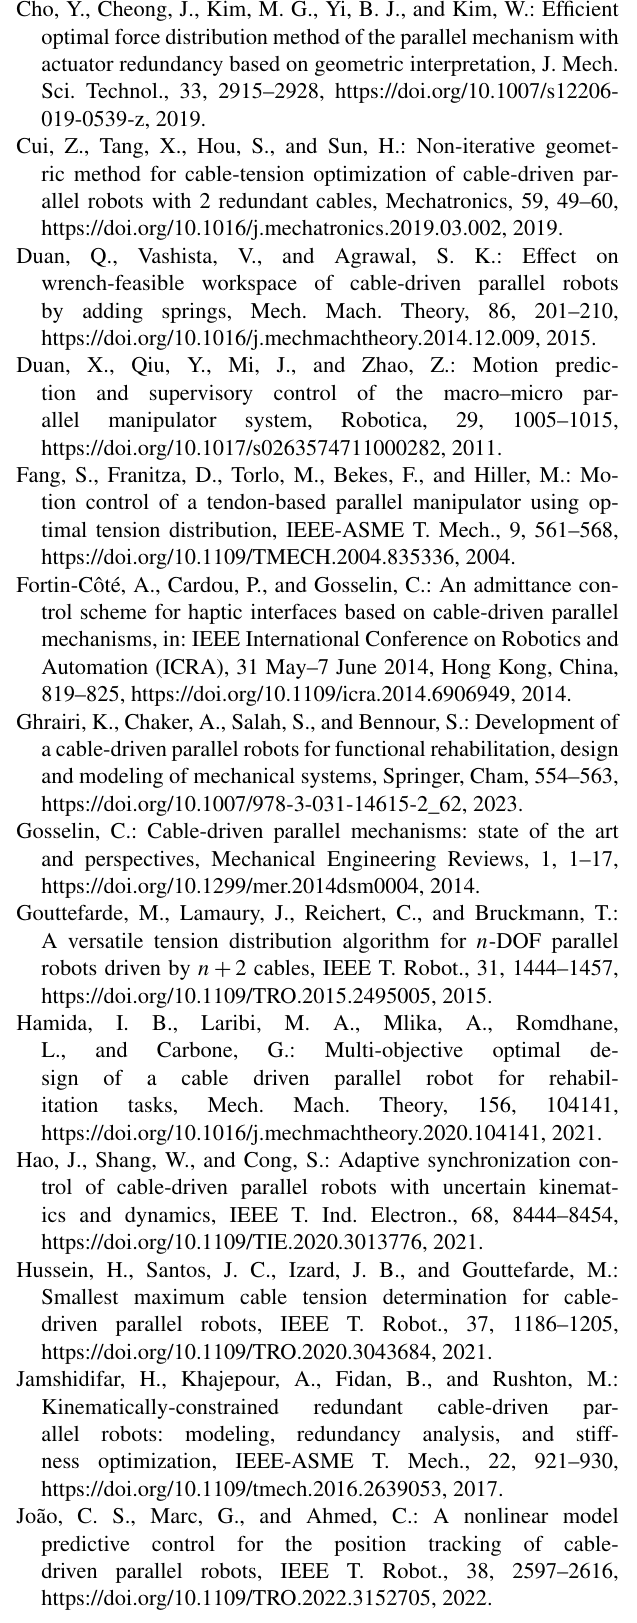
figuration topology, kinematics model, and tension distribution.